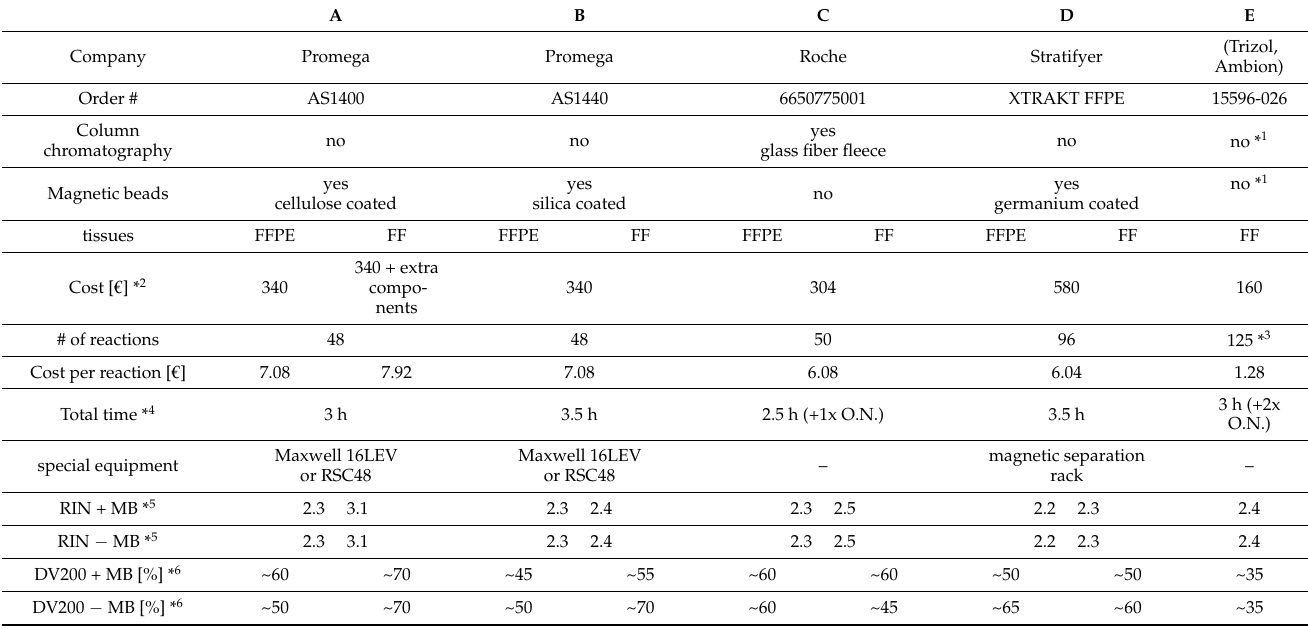
Table 1. RNA isolation methods